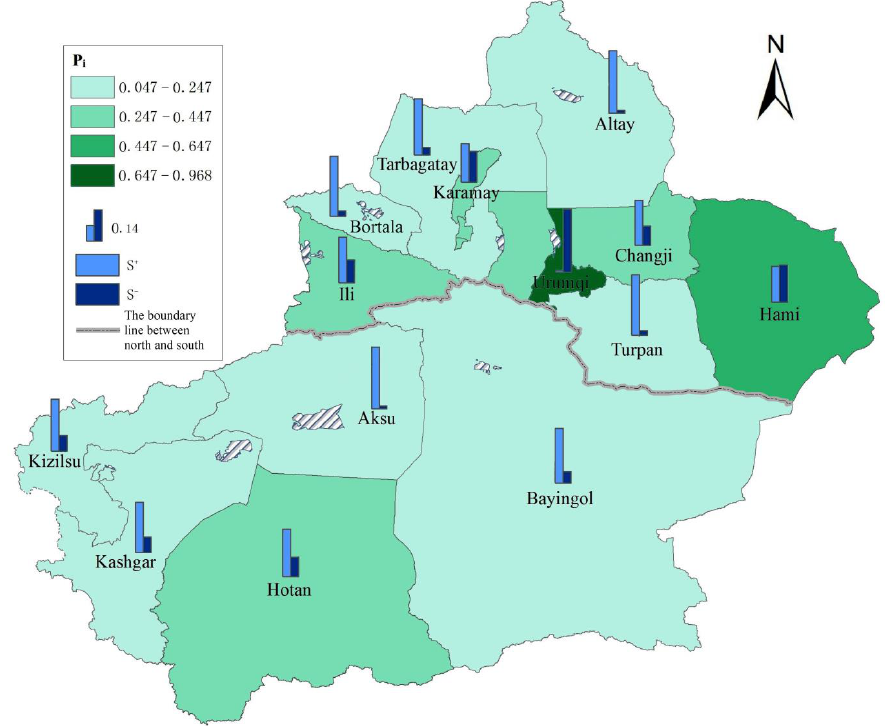
Figure 9. Spatial distribution of S + , S − and P i